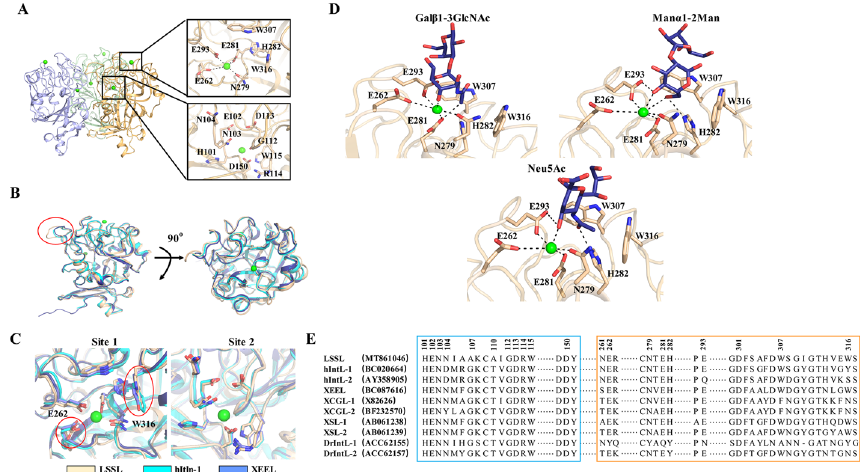
Fig. 3 Comparative analysis of LSSL, hIntL-1, and XEEL. A Structure of the LSSL trimer with two calcium-ion-binding sites oriented with the intelectin-specific domains toward the top of and the fibrinogen-like lobes below the figure. Calcium site with two calcium ions (green) and no water molecules. The other calcium is buried deep in the protein core. B , C Comparison of the structure of lectins from lamprey (wheat), Xenopus (blue), and humans (cyan). The overall structure is shown in B . The Ca 2 + binding site 1 and site 2 are shown in C . D Docking of Galβ1-3GlcNAc, Manα1-2Man, and Neu5Ac in the LSSL structure. The calcium ions are shown in green. E Sequence ratio pairs of XEEL and intelectins from humans [hIntL-1 (human intelectin-1) and hIntL-2 (human intelectin-2)] and common model organisms (XCGL-1, XCGL-2, XSL-1, and XSL-2 from X. laevis ; mIntL-1 and mIntL-2 from mouse; DrIntL-1 and DrIntL-2 from zebrafish). The corresponding GenBank accession numbers are included in the second column. Residues in the structural calcium site and ligand-binding site are highlighted in blue (LSSL) and orange (hIntL-1/XEEL),